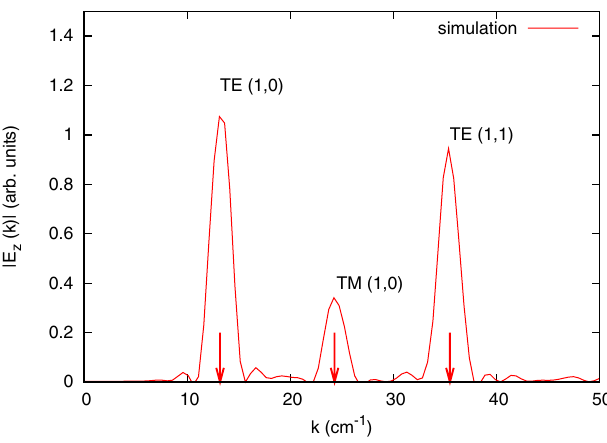
(cid:1) FIG. 8. (Color) Power spectrum of E (taken at x; y (cid:1) 0 ) from z z CSR in steady state in a square toroidal waveguide, showing the three lowest frequency synchronous modes. The bending radius is 120 cm, and the width and height are 2.5 cm. The three modes have predicted wave numbers of 13.2, 24.3, and 35 : 5 cm (cid:4) 1 , respectively. The beam is a fixed three-dimensional Gaussian (cid:1) 0 : 028 cm and (cid:4) (cid:1) 0 : 07 cm with (cid:4) ? z